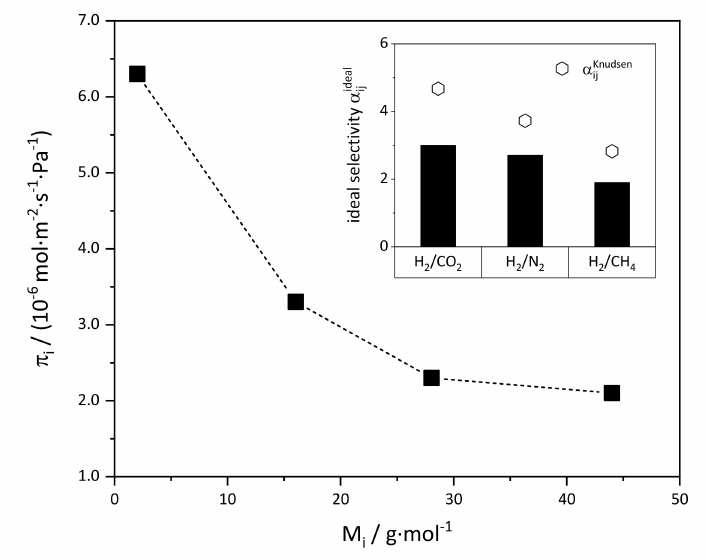
Figure 13. Single gas permeance (T = 25 ◦ C, ∆ p = 1 bar) through a ZIF-11 membrane (Mott/dr/h/6h) as a function of the molecular mass of the measured gas M i . The membrane was prepared by drop seeding and 6 h of secondary growth in DEF at 60 ◦